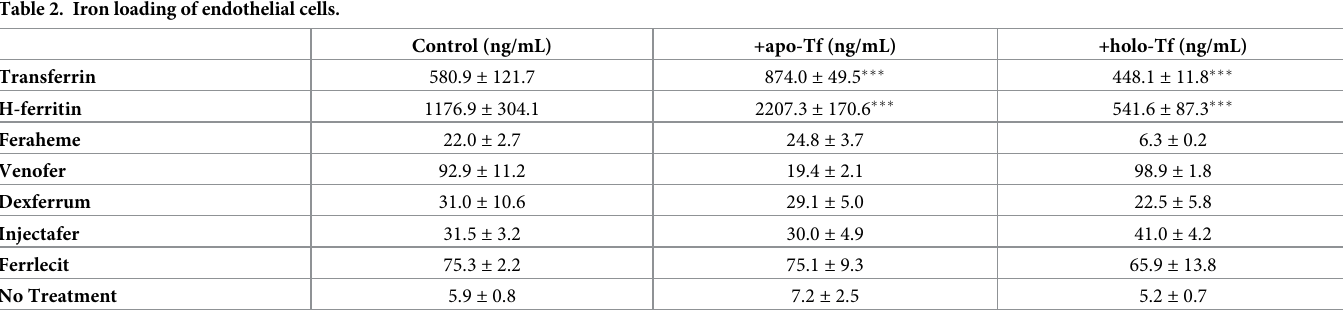
Table 2. Iron loading of endothelial